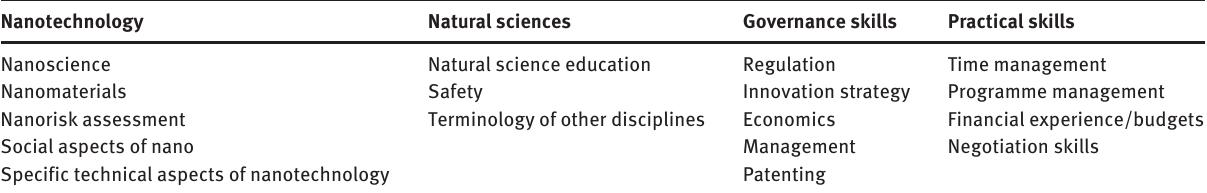
Table 4 Topics ST&I promoters would like to learn